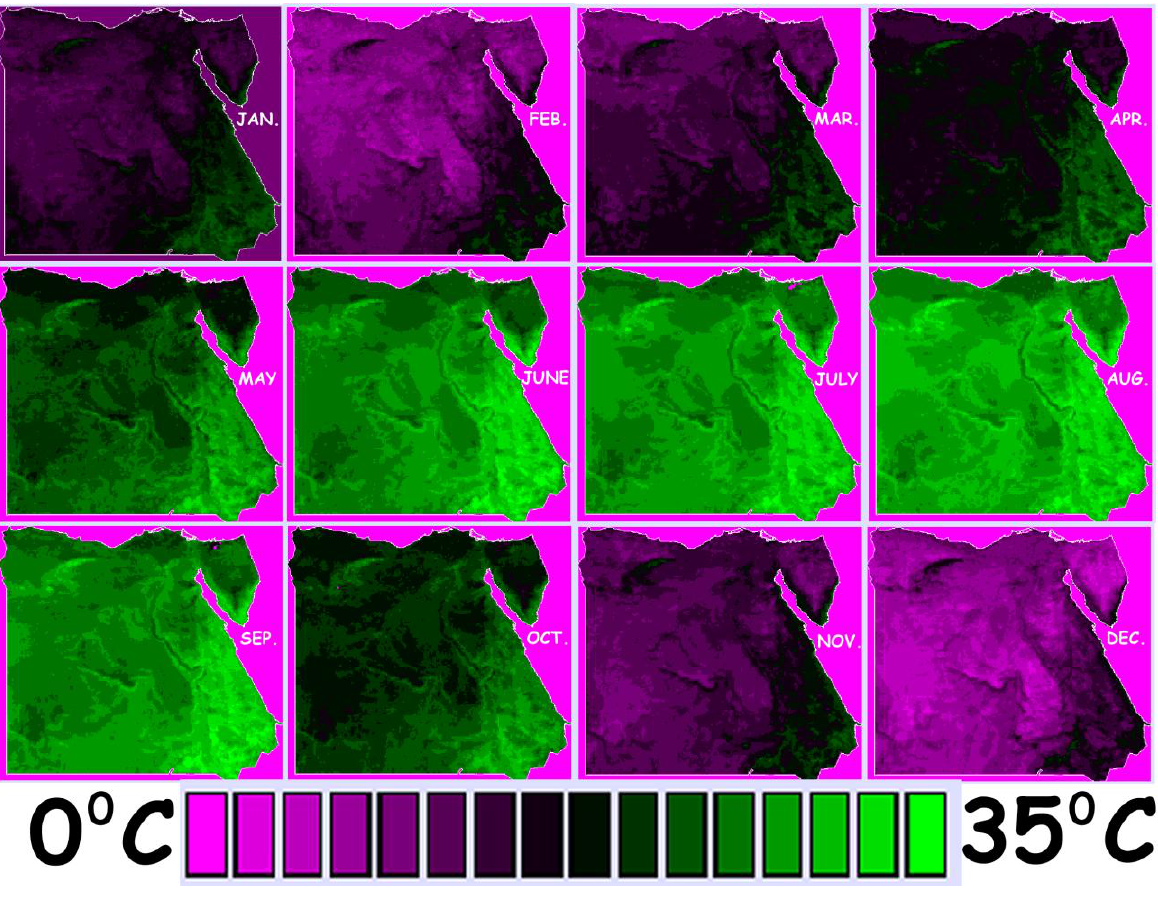
Figure 2. Monthly night land surface temperature (LST) values (the darker a pixel is, the greater the LST). From March to October the Nile River is easily identified due to the observed lower LST values compared to the surrounding